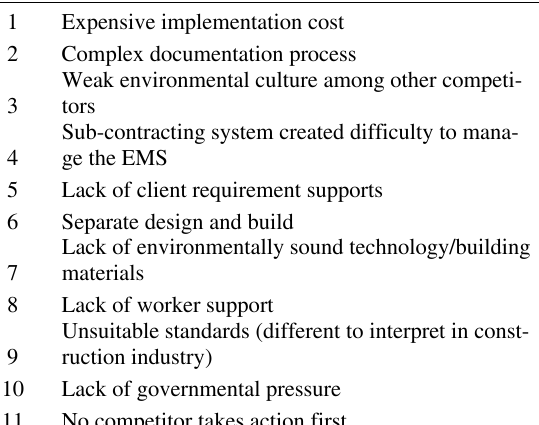
Table 5. List of perceived barriers in implementing an ISO